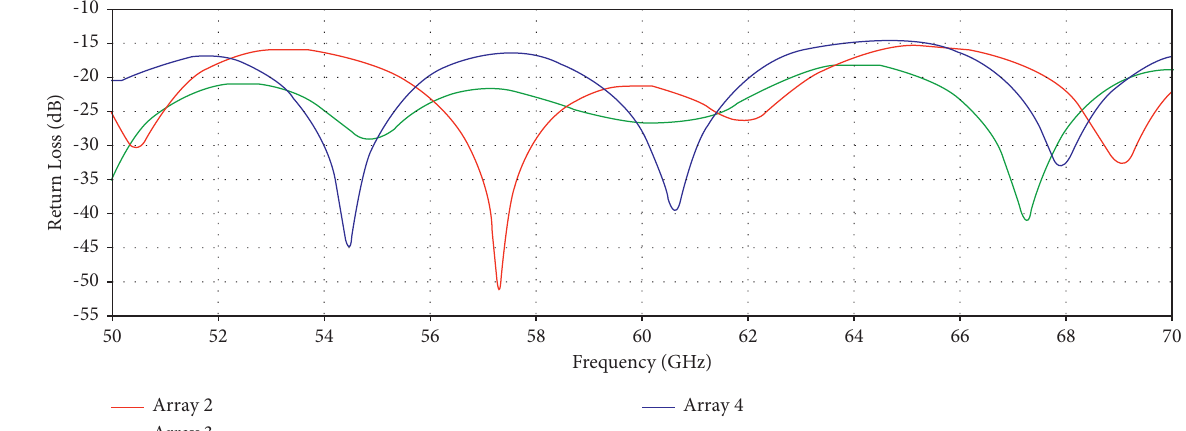
Figure 7: Simulated free-space return loss comparison.